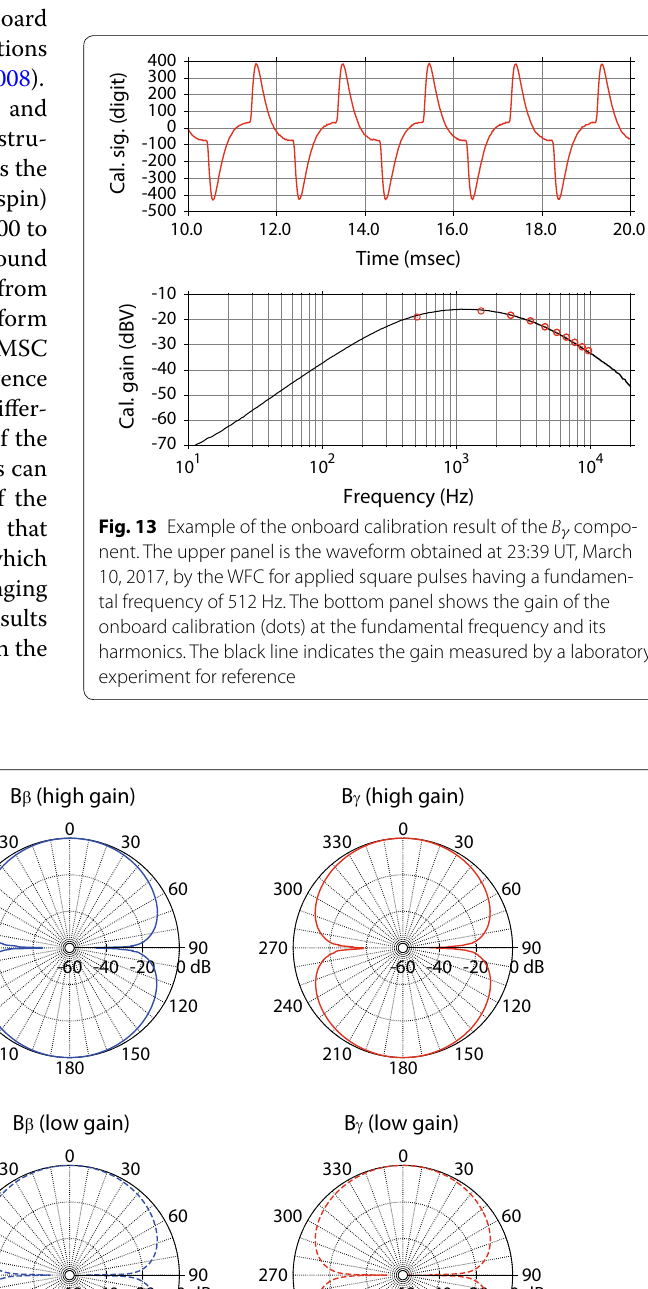
Fig. 12 Directionality measurement results. The null depths reach down to